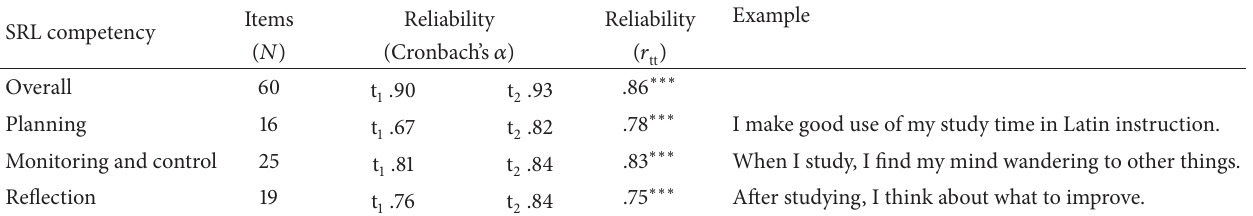
Table 2: Summary of reliability estimates for general self-regulated learning competency, on the overall scale and on the scales planning, monitoring and control, and reflection.